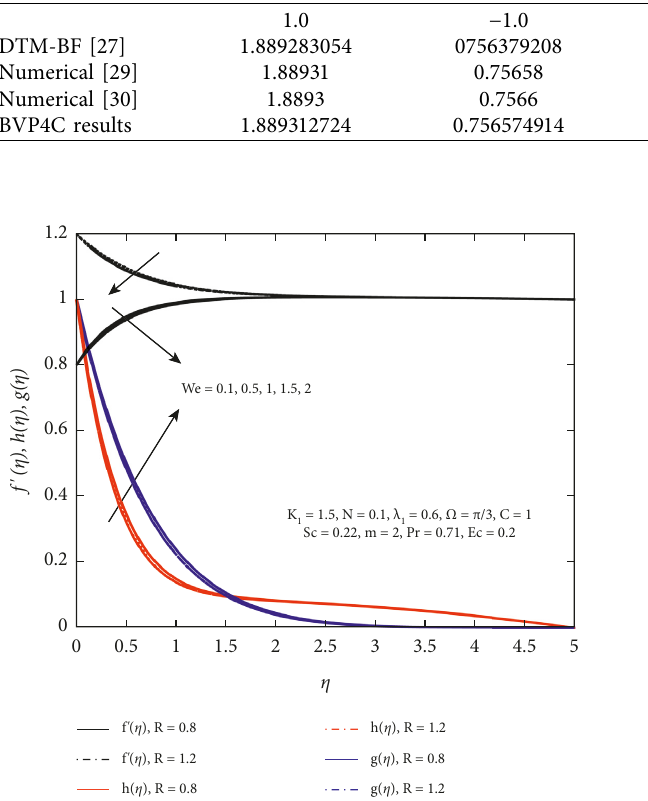
0 for various choices of C 1 . ( ) ″